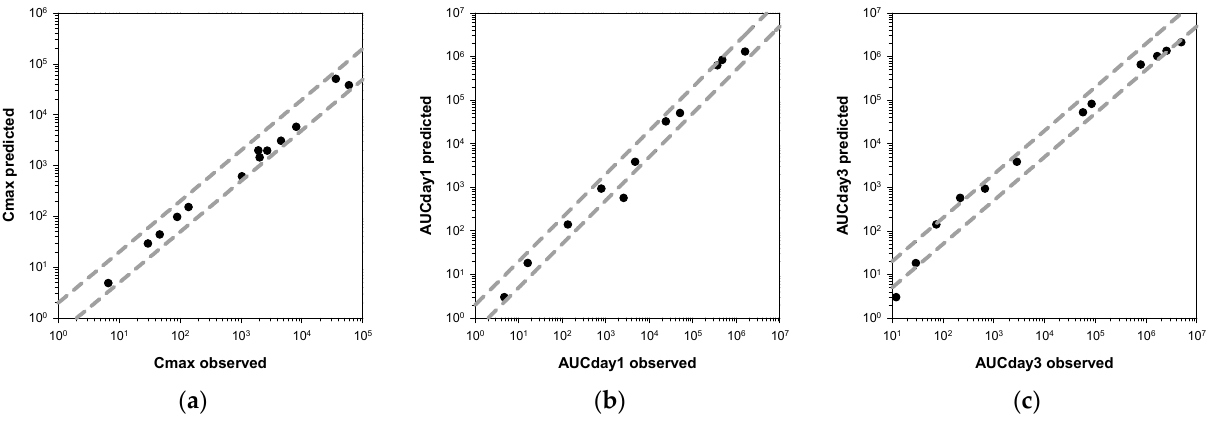
Figure 5. Comparison of the observed and predicted PK parameters. ( a ) C max ; ( b ) AUC Day1 ; ( c ) AUC Day3 . The dashed lines represent 2-fold errors between the observations and predictions.